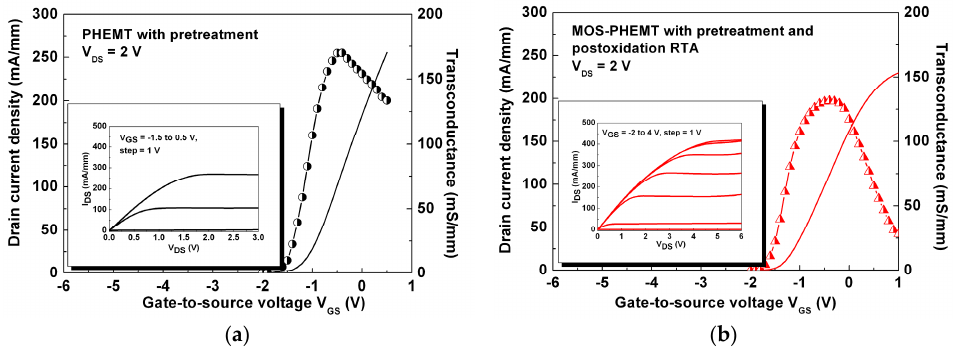
Figure 3. ( a ) Measured I-V characteristics and related transconductance curves for referenced PHEMT. ( b ) Measured I-V characteristics and related transconductance curves for MOS-PHEMT.